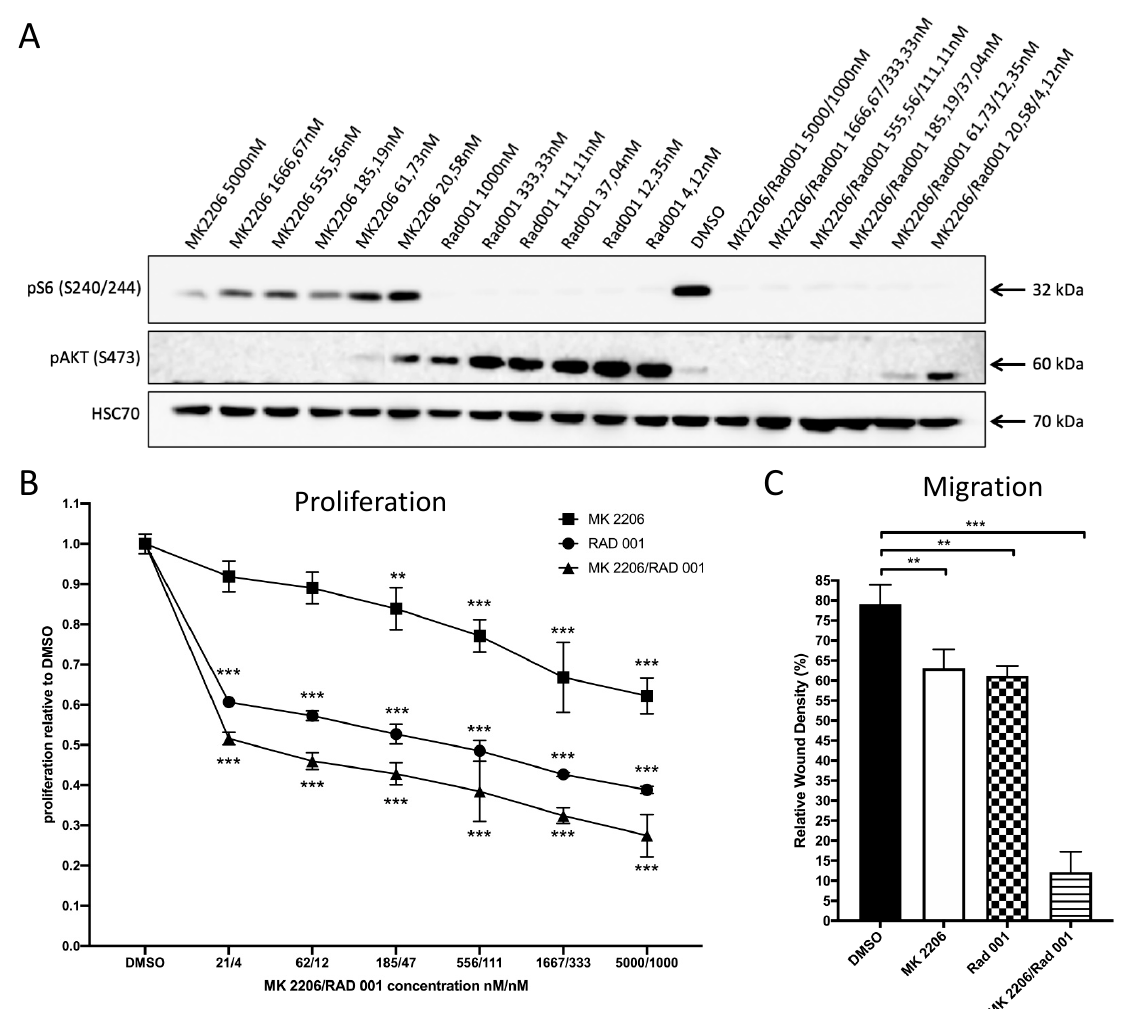
Figure 2. Treatment of 231-BO cells with the panAKT inhibitor MK2206 and the mTOR inhibitor RAD001 either alone or in combination inhibits proliferation and migration: ( A ) 231-BO cells were treated with MK2206 and RAD001 either alone or in combination with various concentrations for 24 h before preparing whole cell lysates. Inhibition of AKT (pAKT S473) and mTOR (pS6 S240/244) were confirmed by Western blot analysis using antibodies directed against the indicated proteins. HSC70 functions as a loading control. ( B ) 231-BO cells were seeded into a 96-well plate and were treated with various concentrations of MK2206 and RAD001 either alone or in combination for 72 h. Control cells were treated with DMSO. Cell viability was analyzed in triplicate using Alamar blue assay. Data points represent mean with SD; ** = p < 0.01; *** = p < 0.001. ( C ) Migration of 231-BO cells treated with MK2206 5000nM and RAD001 1000nM either alone or in combination was tested by scratch wound healing assay. Relative wound density was analyzed using the IncuCyte live cell imaging system. Bars indicate mean of triplicates with SD; ** = p < 0.01; *** = p <